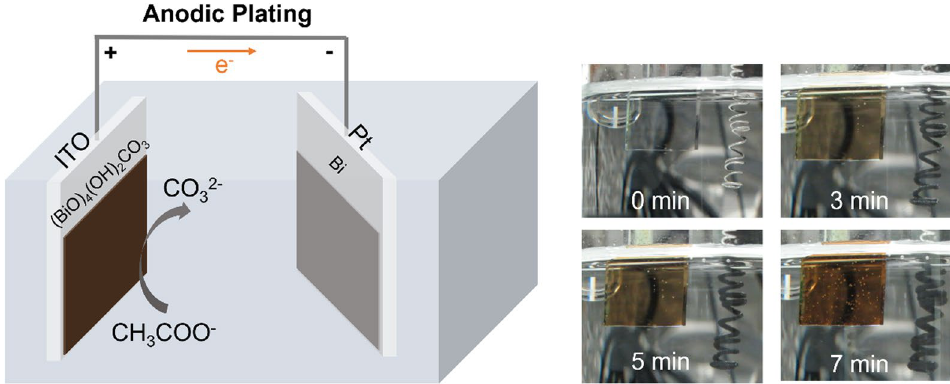
Fig. 1 Schematic of the anodic plating for depositing (BiO)